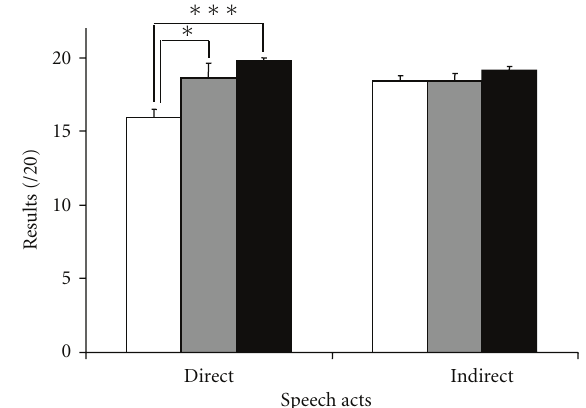
Figure 2: Direct and indirect speech act mean results ( ± SEM) for participants with Parkinson’s disease with (white column) and without (grey column) depressive symptoms and healthy controls (black